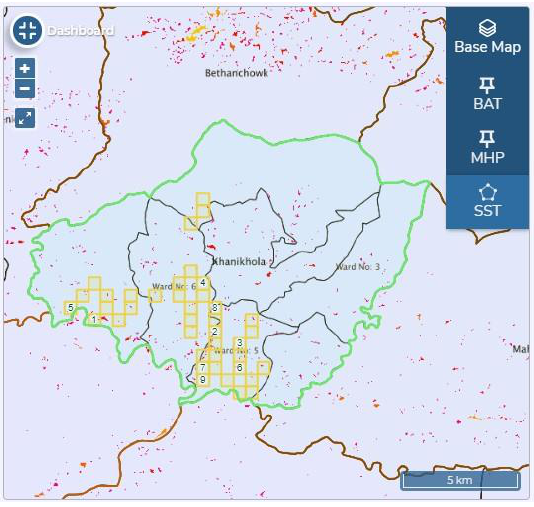
Figure 4. Distribution of grid samples (municipal boundary: green; ward boundary: black; and grid sample: yellow).